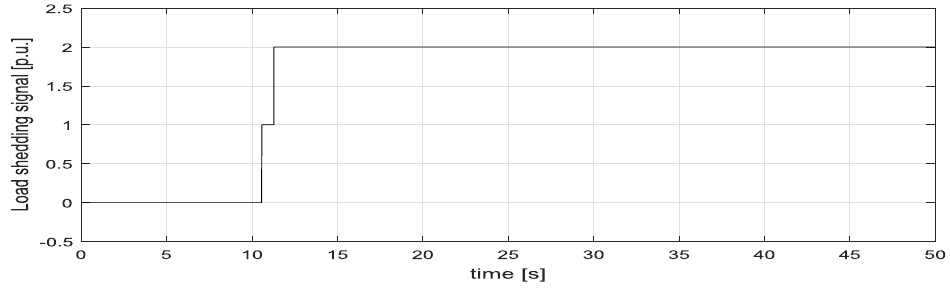
Figure 11. Load shedding control signal sent by the EMS.